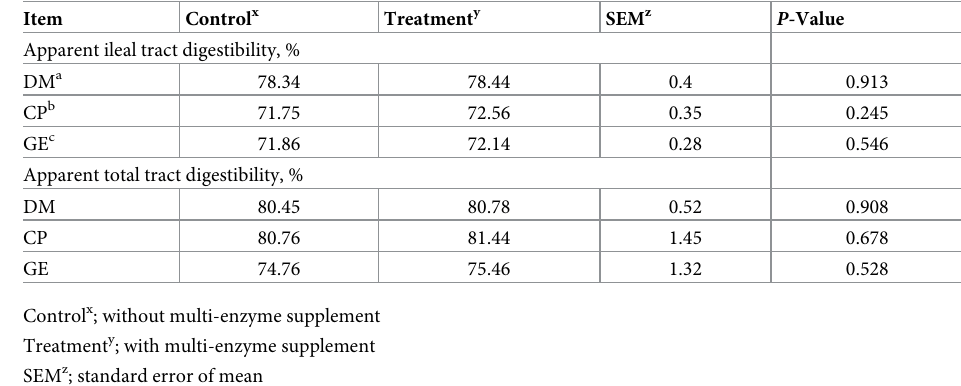
Table 4. Apparent digestibility of nutrients in pigs fed diets with multi-enzyme